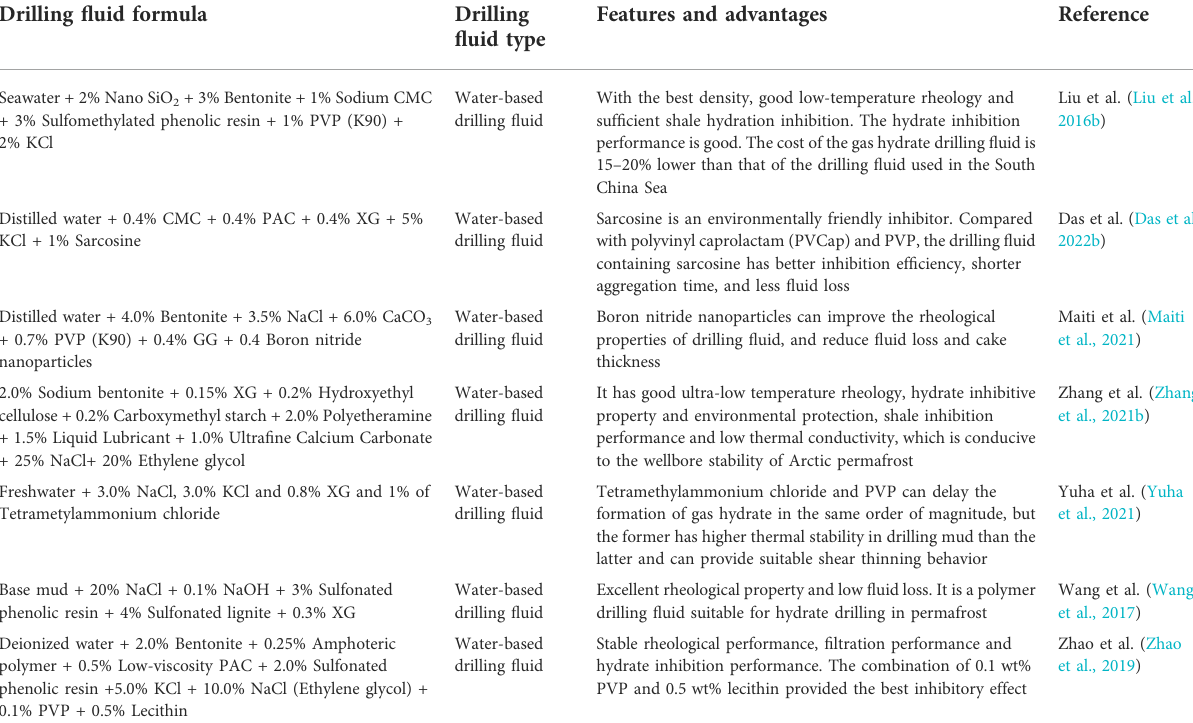
TABLE 4 Gas hydrate drilling fl uid developed in recent